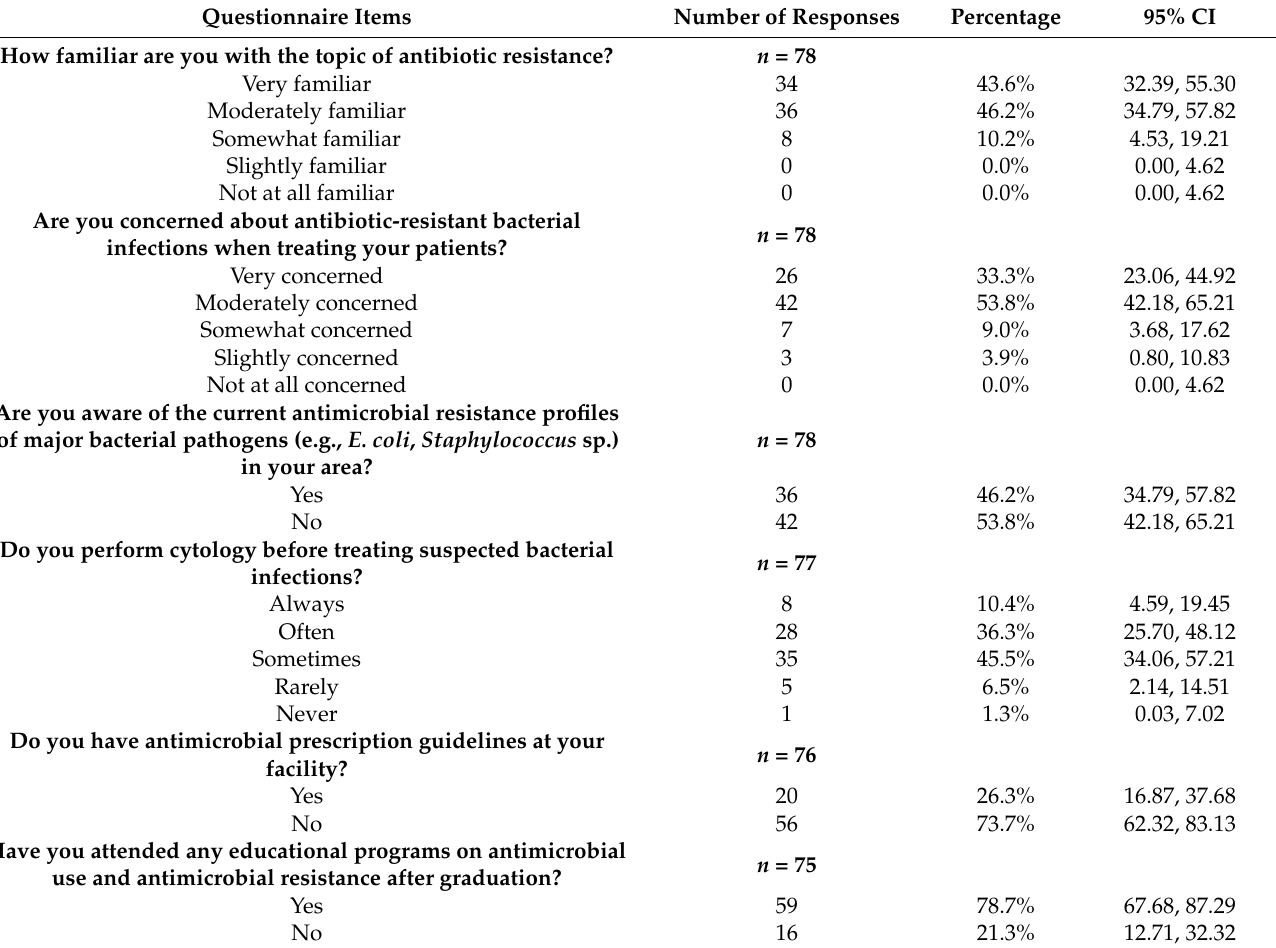
Table 2. Awareness of antimicrobial resistance and antimicrobial use practices among Illinois small animal